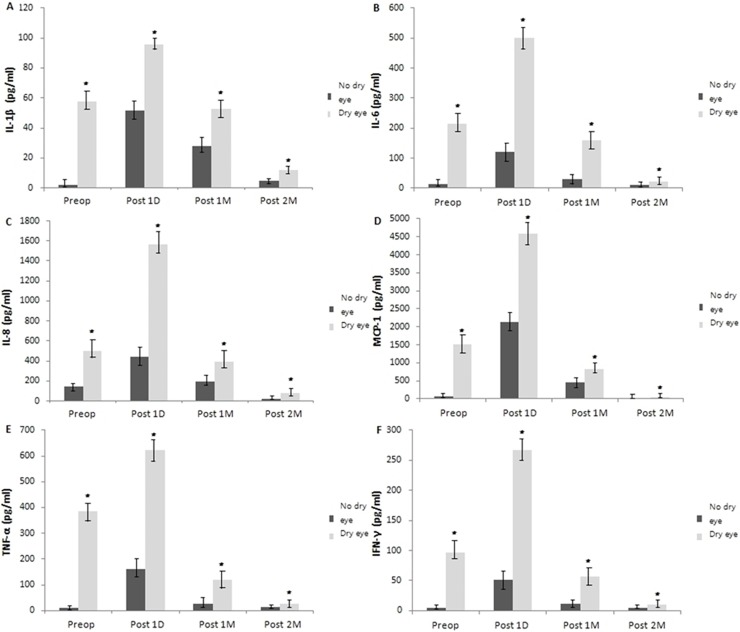
Change in concentration of cytokines and chemokines in lacrimal tears from preoperative value.The decrease in concentrations of IL-1β, IL-6, IL-8, MCP-1, TNF-α and IFN-γ in lacrimal tears was statistically significant in the dry eye group at 1, and 2 months compared to the value of 1 day post-surgery, respectively (P <0.05). Each value represents the mean ± standard error of the mean (SEM). Significance was evaluated with random-effects analysis of variance (ANOVA) model; p values of <0.05 were considered statistically significant. ***P < .001, **P < .01, *P < .05, using a linear mixed model with post hoc analysis, or generalized estimating equations model.